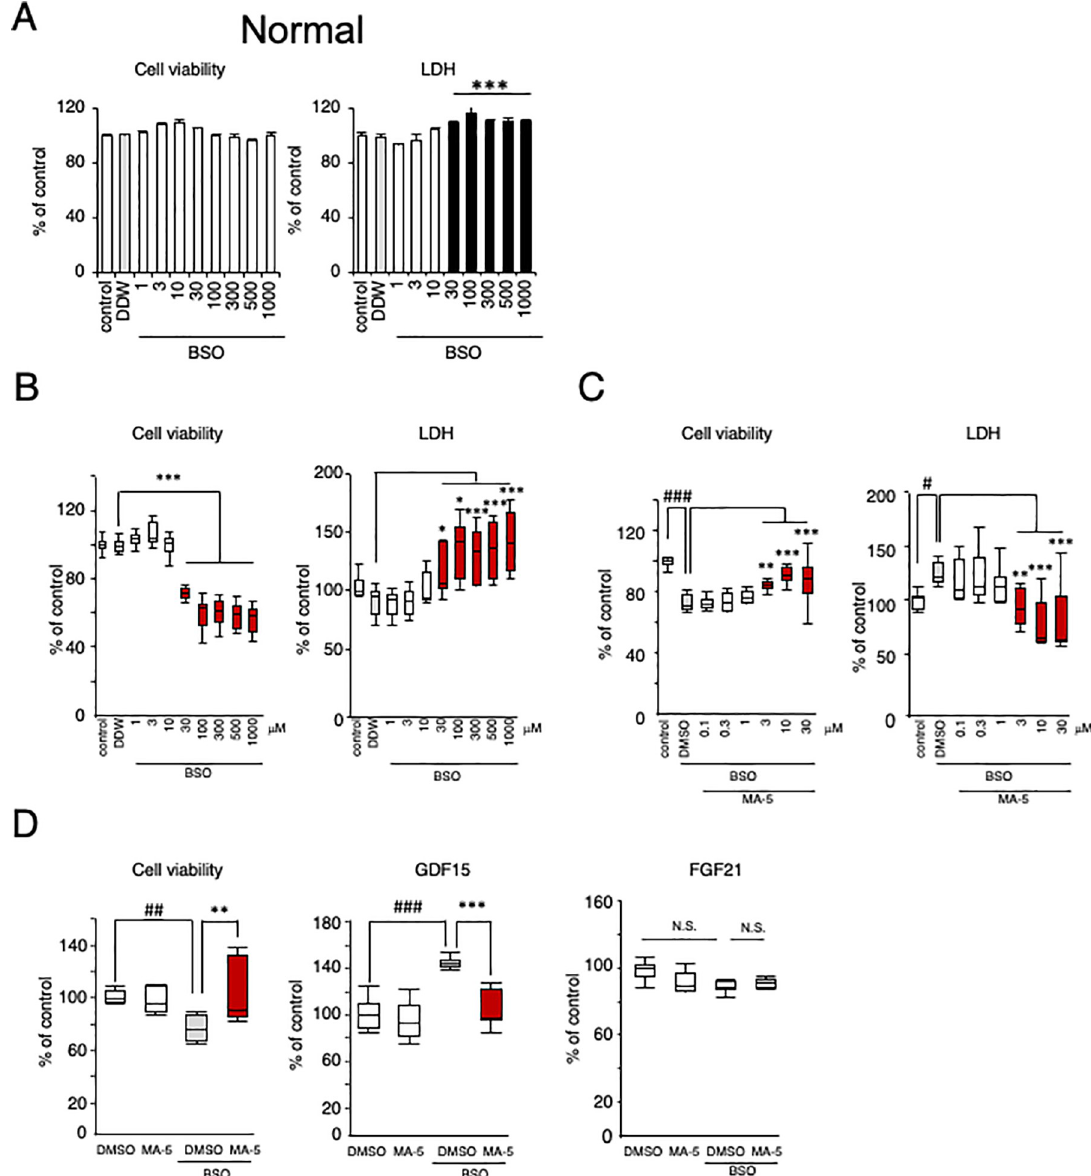
Fig 4. Cell protective effect of MA-5 on sIBM myoblasts. A. Sensitivity of normal control myoblasts to BSO. The data represent the mean ± SE. ��� p < 0.001 (two-way ANOVA and Tukey-Kramer test versus DDW). B. Sensitivity of sIBM patient myoblasts to BSO, as measured by the cell viability assay and the level of LDH in the culture medium. The data represent the mean ± SEM. � p < 0.05, ��� p < 0.001 (two-way ANOVA and Tukey-Kramer test versus BSO + DDW). The red square indicates a significant increase or decreased compared with DDW. C. Cell protective effect of MA-5 on sIBM myoblasts, as measured by the cell viability assay and the level of LDH in the culture medium. The data represent the mean ± SEM. # p < 0.05, ### p < 0.001 (two-way ANOVA and Tukey post hoc test versus control); �� p < 0.01, ��� p < 0.001 (two-way ANOVA and Tukey-Kramer test versus BSO + DMSO). The red square indicates a significant increase or decrease compared with DMSO. D. Measurement of sIBM patient myoblasts by the cell viability assay (left panel) after 72-h DMSO application as a control or 72-h 10 μ M MA-5 treatment under oxidative stress conditions induced by 24-h BSO treatment. The levels of GDF15 (middle panel) in the medium of cultured myoblasts were measured in the same manner. The levels of FGF21 (right panel) in the medium of cultured myoblasts were measured in the same manner. The data represent the mean ± SE. ## p < 0.01, ### p < 0.001 (two-way ANOVA and Tukey-Kramer test versus DMSO); �� p < 0.01, ��� p < 0.001 (two-way ANOVA and Tukey- Kramer test versus BSO +